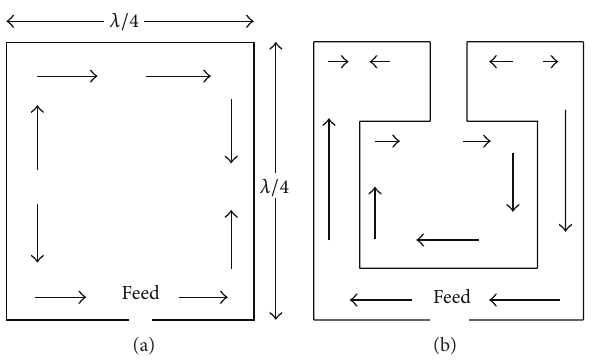
Figure 1: Current distributions of (a) one-wavelength-perimeter loop and (b) folded-dipole loop.